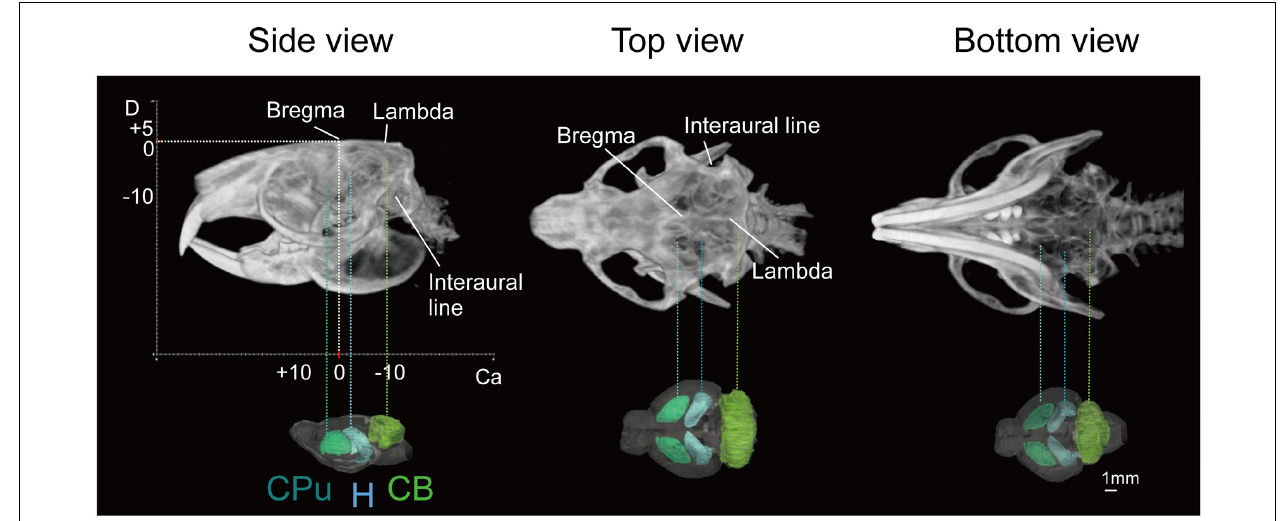
FIGURE 1 |Volume-rendered skull images with stereotaxic coordinates (left, side view; center, top view; right, bottom view) together with whole brain images displaying the approximate locations of major regions caudate putamen (CPu, light green), cerebellum (CB, green), and hippocampus (H, light blue). Scale bar = 1